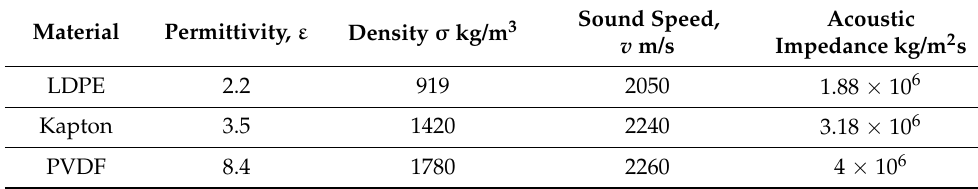
Table 1. Selected electrical and mechanical parameters of tested samples [21,37,48].